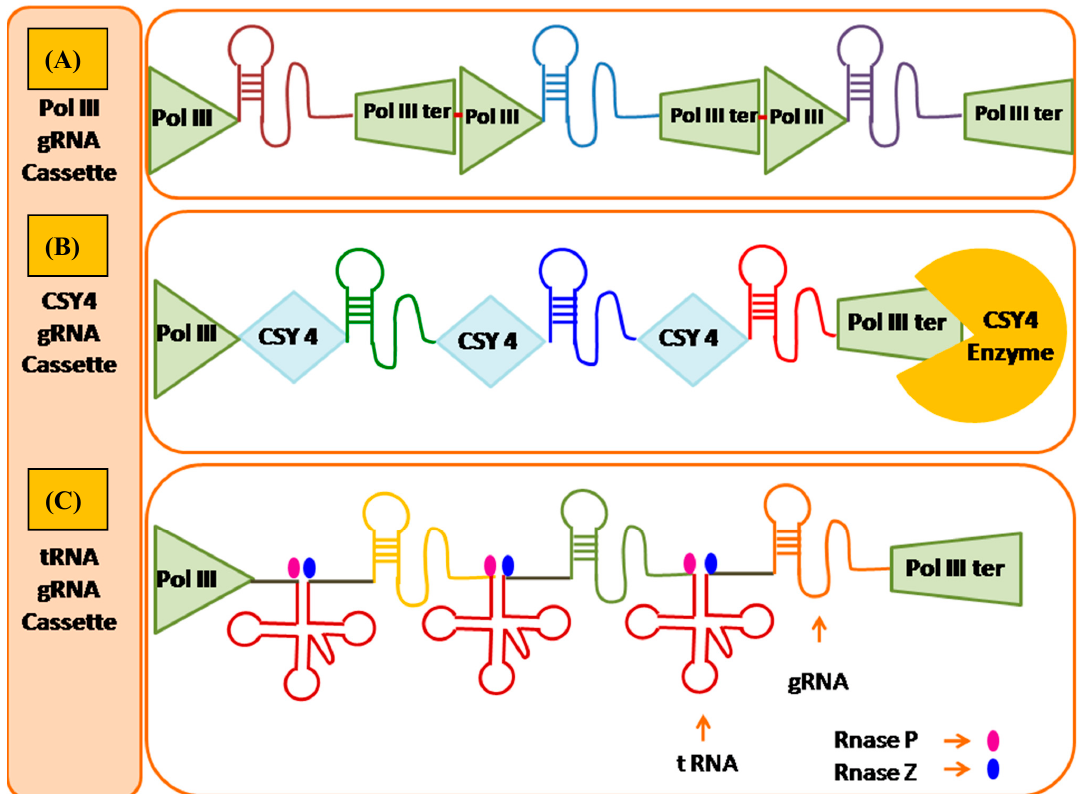
Figure 1: Overview of various approaches for multigene targeting using CRISPR/Cas9 technology. ( A ) Pol III-gRNA cassette comprises Pol III promoter followed by SgRNA and Pol III terminator respectively. Here each SgRNA uses separate promoter and terminator for expression. ( B ) CSY4-gRNA cassette contains repeated units of CSY4 and different conserved gRNAs. At the end CSY4 endonuclease gene (yellow in color) also cloned in the vector which cleaves at restriction sites present in CSY4 (blue color rhombus) that ultimately separates various SgRNAs, which can further proceed for genome editing. ( C ) tRNA-gRNA Cassette comprises alternate units of eukaryotic Pre-tRNA (red color clover leaf structure) and conserved gRNAs (different colored structures), that is cleaved by RNaseP (pink circle) and RNaseZ (blue circle) to liberate mature tRNAs. These separated gRNAs can proceed for double strand break by interacting with Cas9 cloned in the same vector.